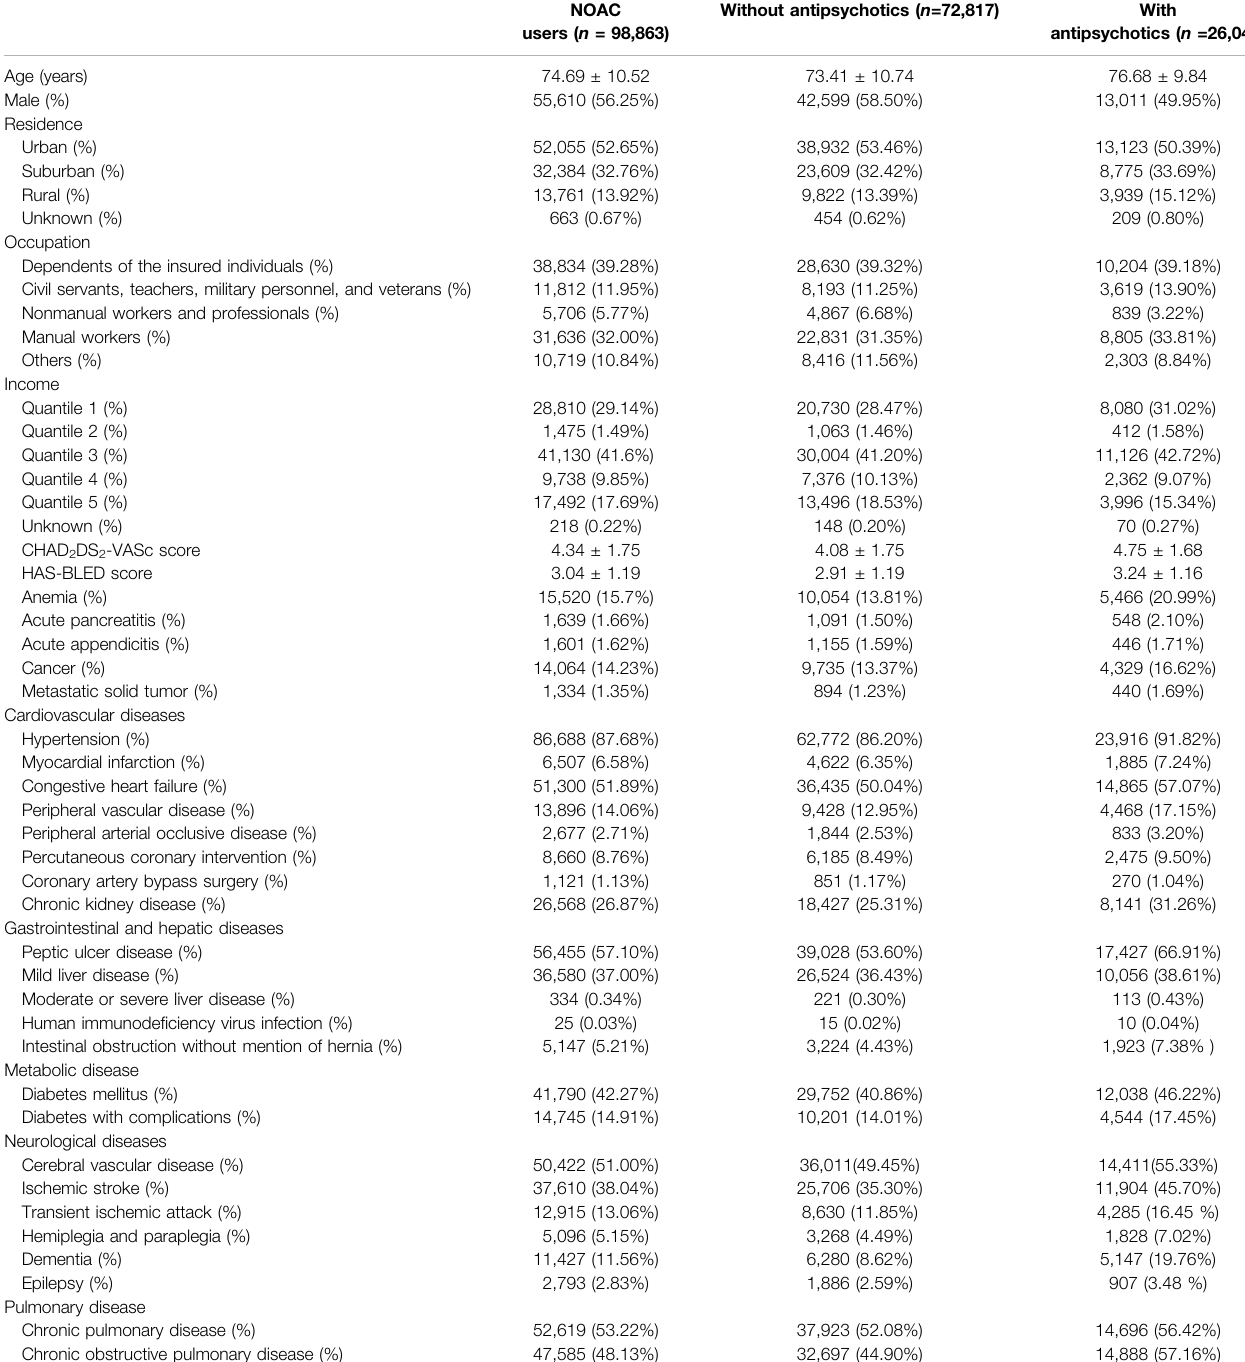
TABLE 1 | Demographic analysis of patients with the use of